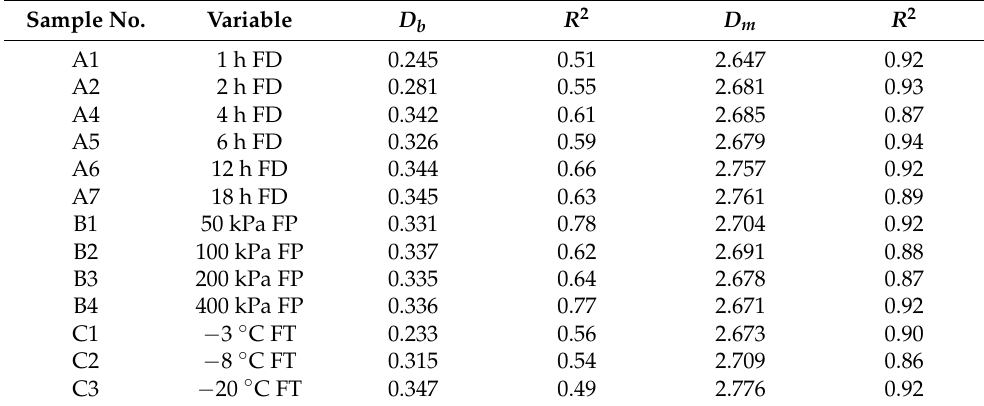
Table 2. Statistical results of nuclear magnetic resonance (NMR) fractal dimensions. Sample